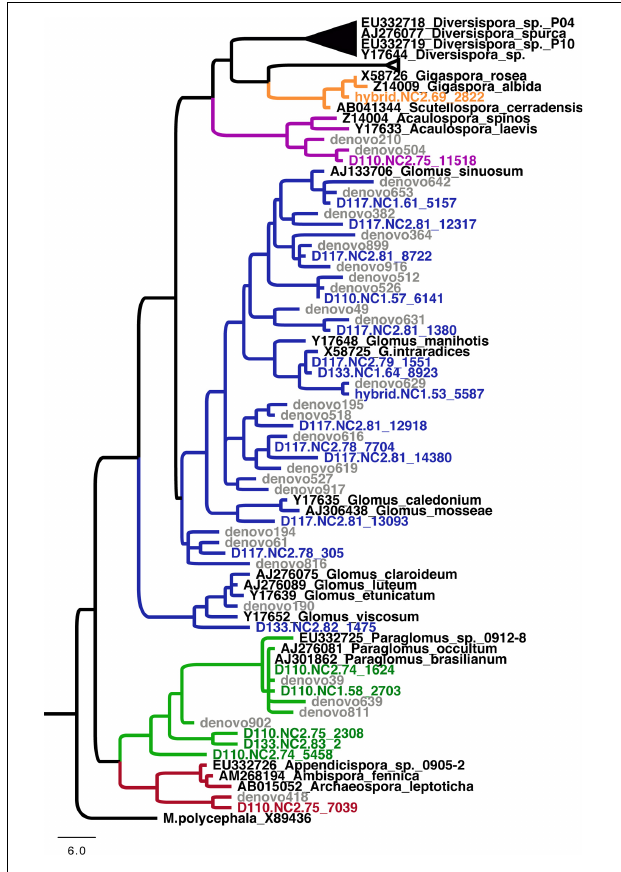
FIGURE 3 | Phylogeny of Glomeromycotina showing the phylogenetic position of arbuscular mycorrhizal fungi detected in this study. Taxonomic families are denoted by colored branches. Black branches denote Diversisporaceae; orange branches denote Gigasporaceae; blue branches denote Glomeraceae; green branches denote Paraglomeraceae; and red branches denote